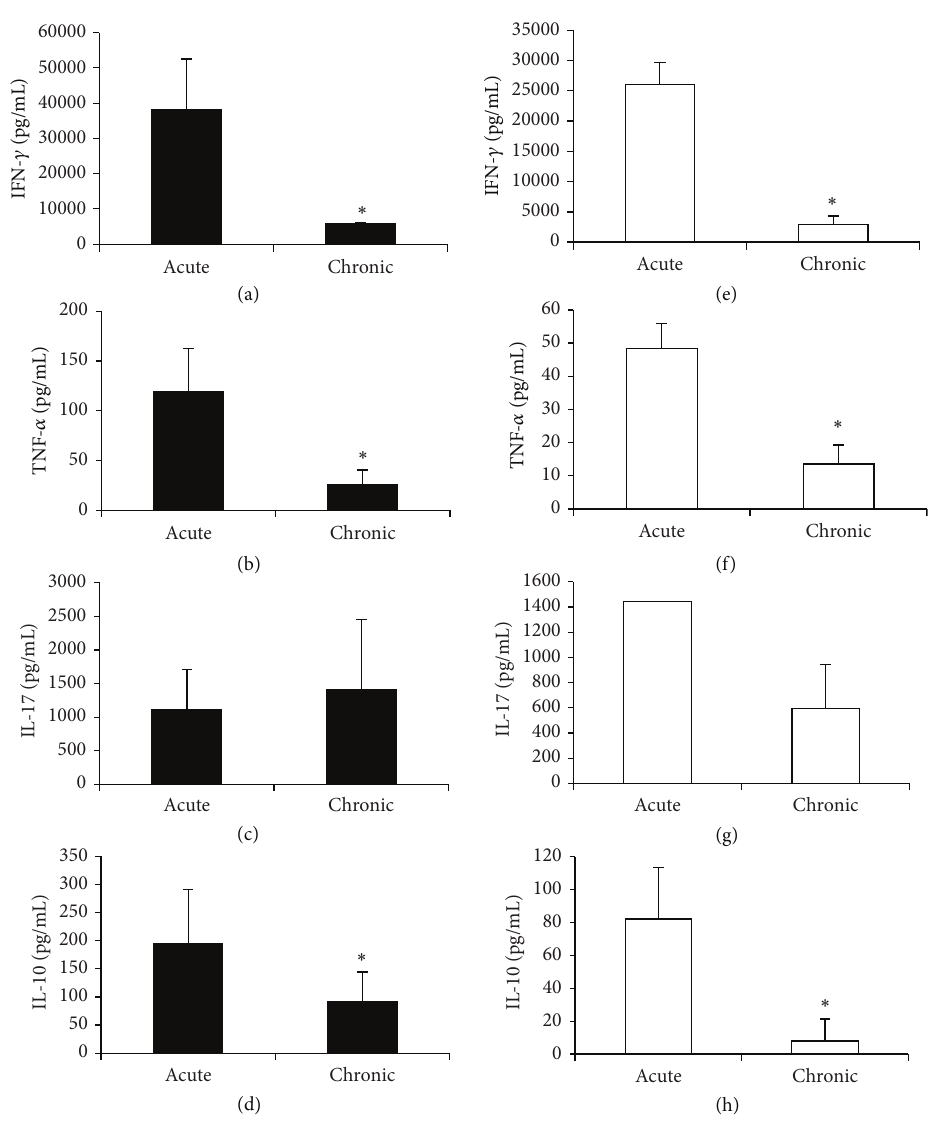
Figure 3: Production of cytokines by peripheral lymphoid organs. C57BL/6 mice were submitted to EAE induction and cytokine production was assayed in acute and chronic EAE stages. IFN- 𝛾 (a and e), TNF- 𝛼 (b and f), IL-17 (c and g), and IL-10 (d and h) levels were measured in spleen (a, b, c, and d) and lymph node cell (e, f, g, and h) cultures stimulated with MOG. Data were presented by mean ± SE of 6 mice and representative of two independent experiments. ∗ 𝑃 < 0.05